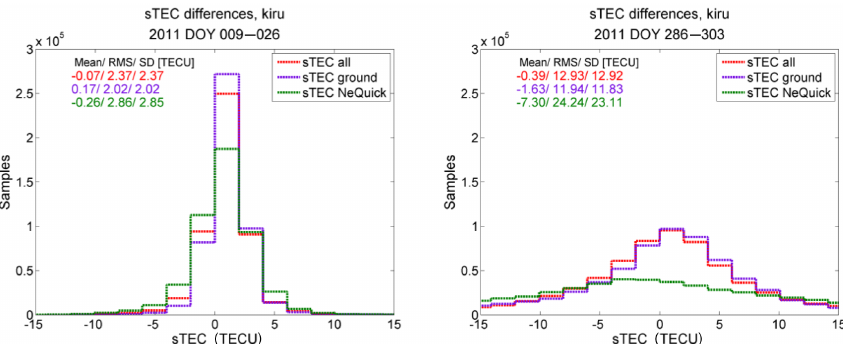
Figure 13. Histograms of sTEC residuals for Kiruna station: DOYs 009–021 (left) and DOYs 286–303 (right) in 2011.